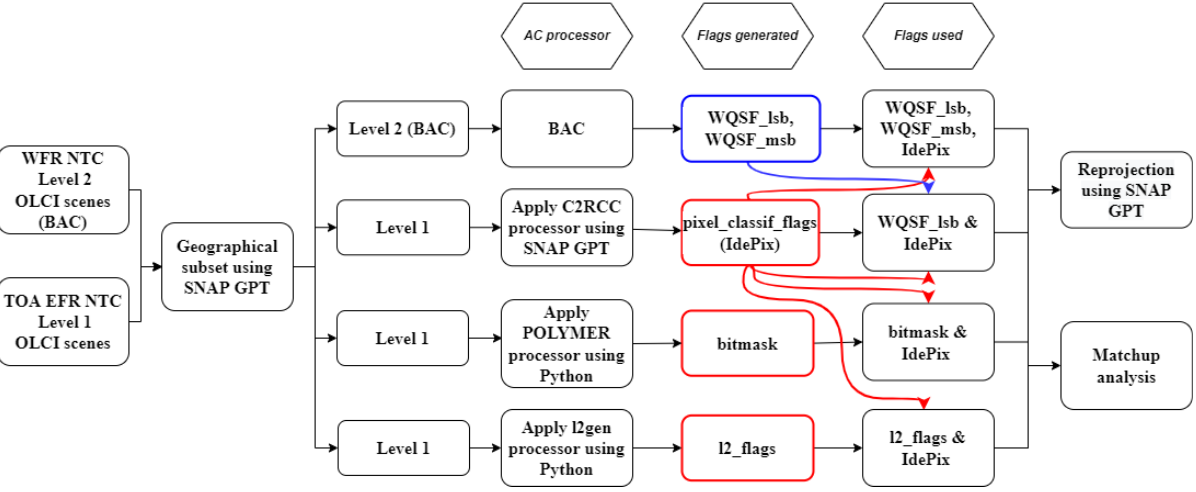
Figure 2. Processing and flagging workflow of four different atmospheric correction processors.